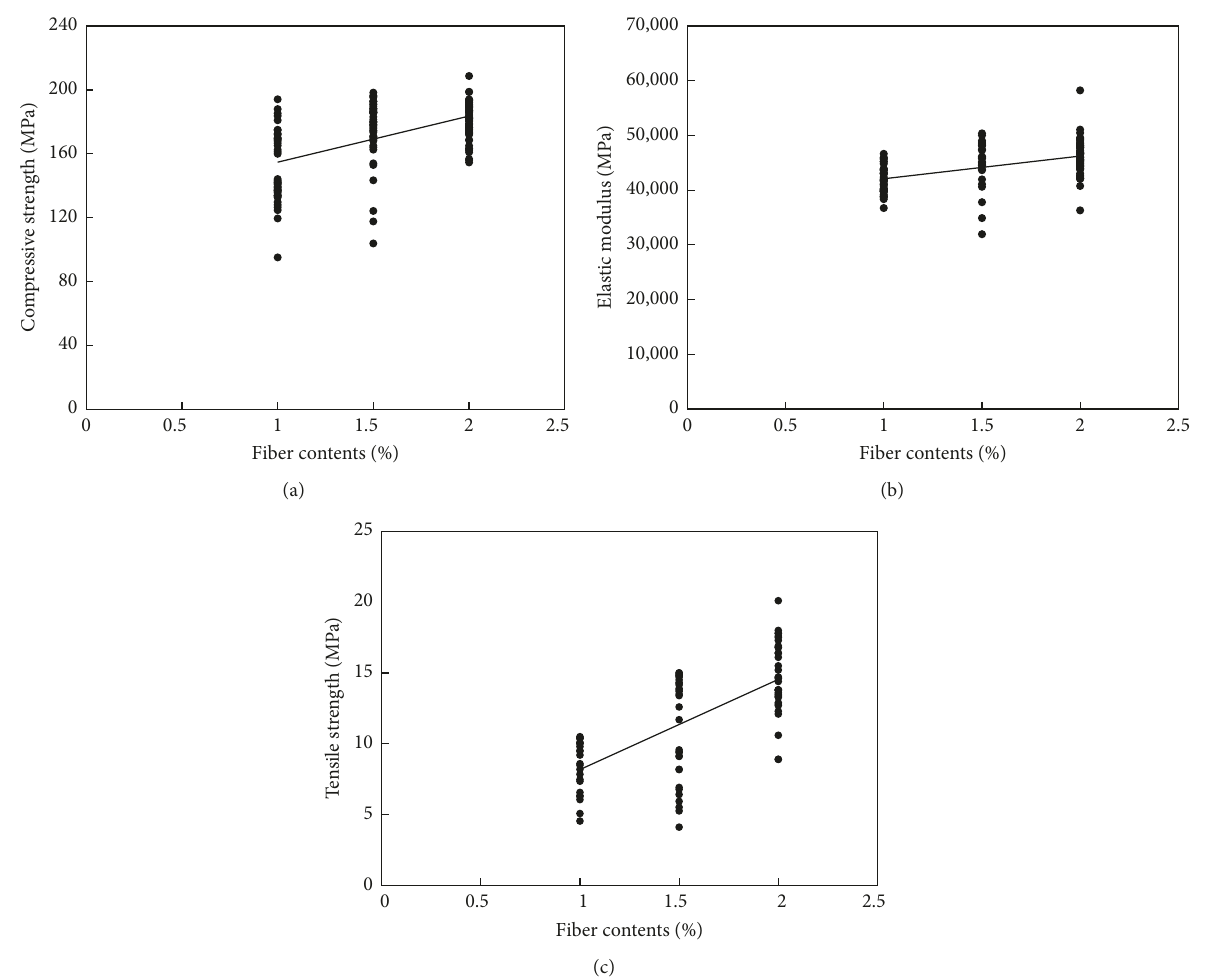
Figure 11: Mechanical properties according to the fiber contents. (a) Compressive strength. (b) Elastic modulus. (c) Tensile